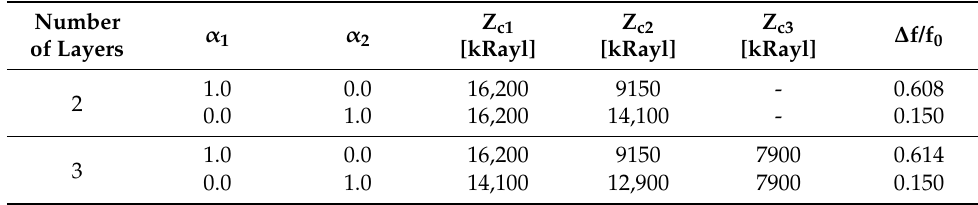
Table 4. Acoustic impedances of the matching layers obtained with the genetic algorithm (skull bone, Z T = 7800